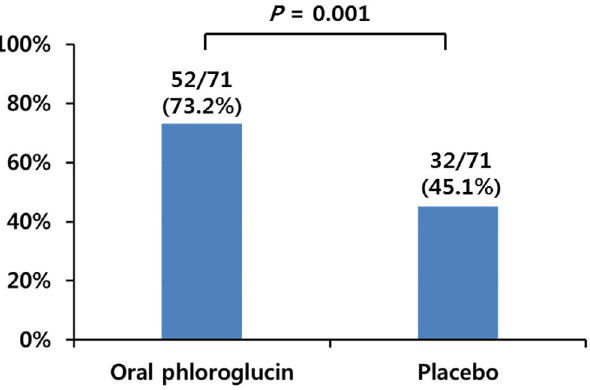
Fig 4. The proportions of subjects who showed acceptable peristalsis d in Phloroglucin and Placebo group. d Acceptable peristalsis includes grade 1 and grade 2.